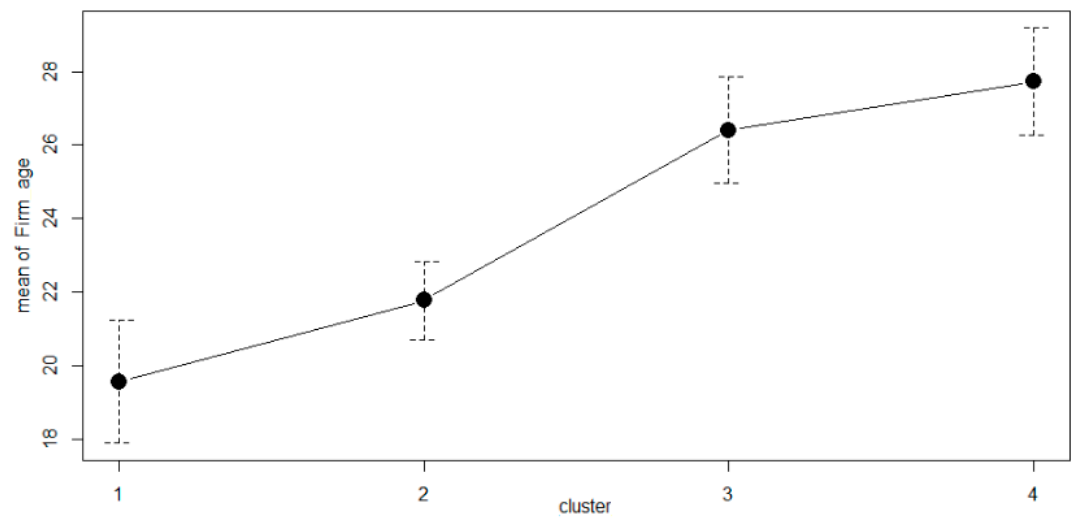
Figure 9. Confidence intervals for the mean company age in each cluster.